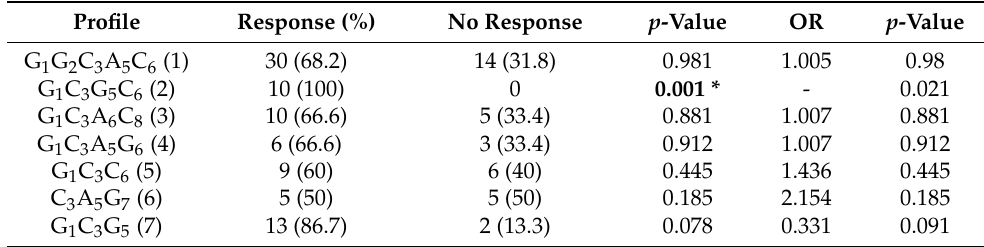
Table 4. Frequency and analysis